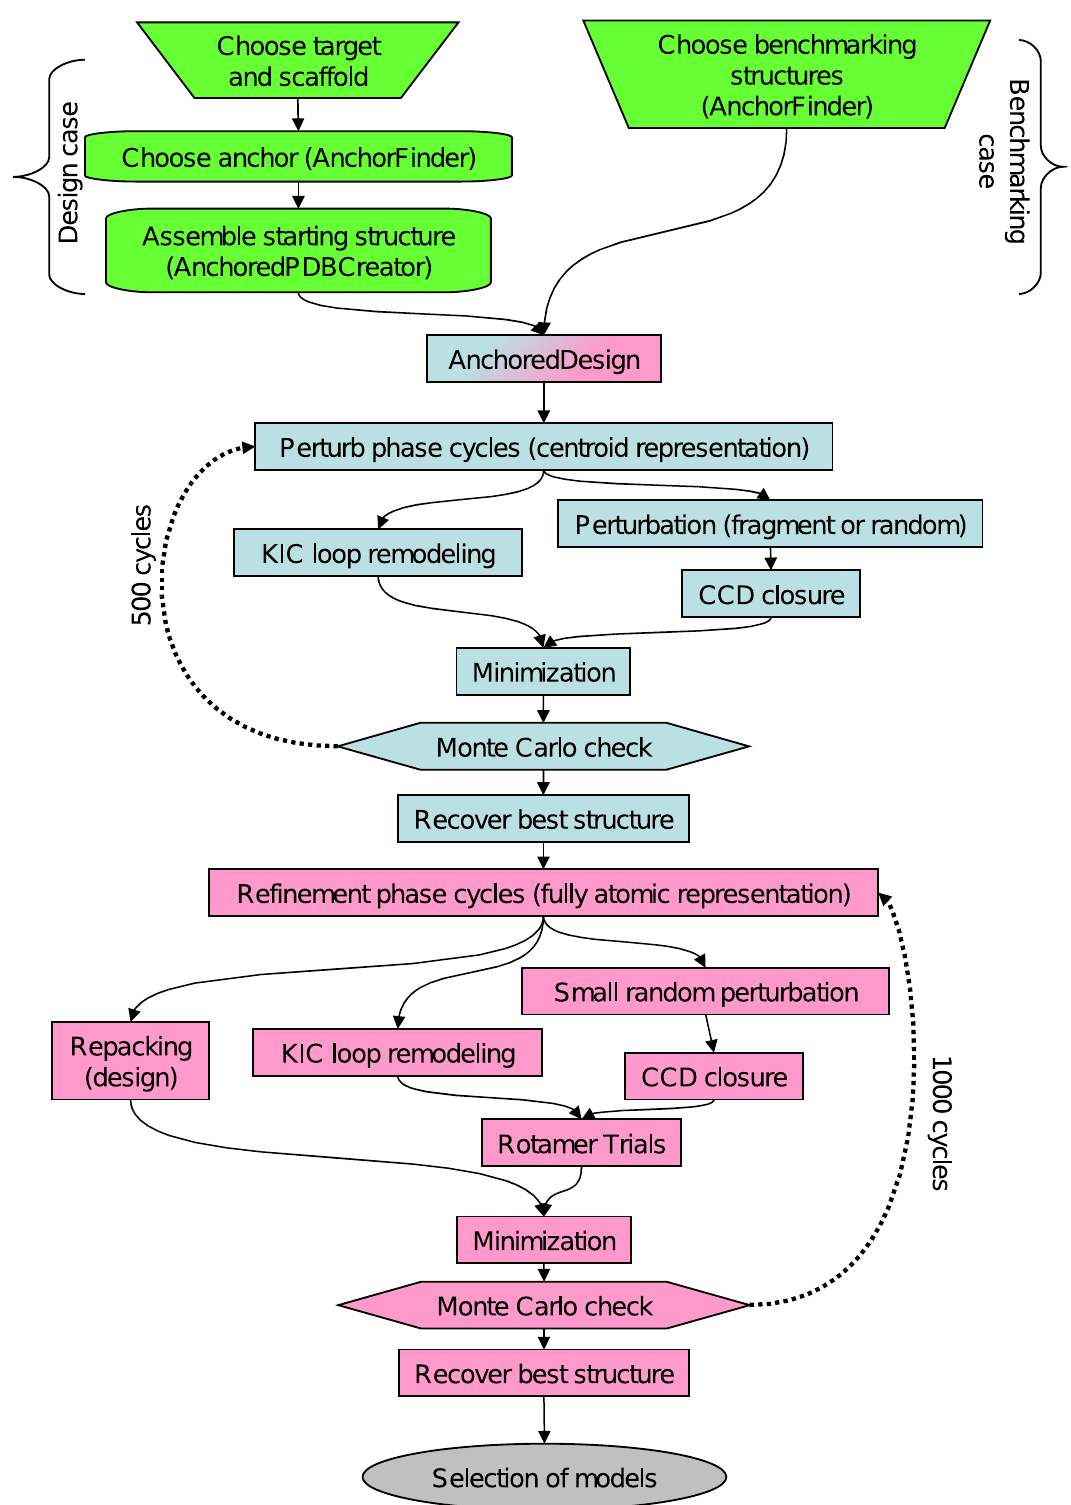
Figure 3. Protocol flowchart. This flowchart summarizes the AnchoredDesign protocol and process. In the top part, preliminary steps are marked in green. These steps are primarily manual but can be assisted with AnchorFinder and AnchoredPDBCreator. Initial steps vary depending on whether the benchmarking case for this paper, or the more general design case, is being addressed. The steps of the AnchoredDesign protocol are shown in blue and pink. The perturbation steps, performed in centroid mode, are in blue. The refinement steps, performed with a fully atomic representation, are in pink. In both portions of the protocol, many Monte Carlo cycles are performed; the results here used 500 perturb and 1000 refine cycles, but optimal cycle counts are best determined on a per-experiment basis. doi:10.1371/journal.pone.0020872.g003 PLoS ONE |